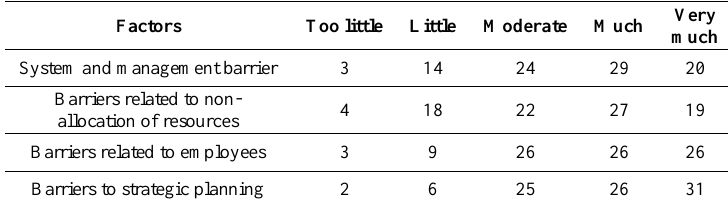
Table 5 . The formation of the data matrix.